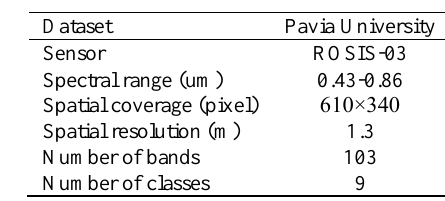
Table 1. The main characteristics of the dataset